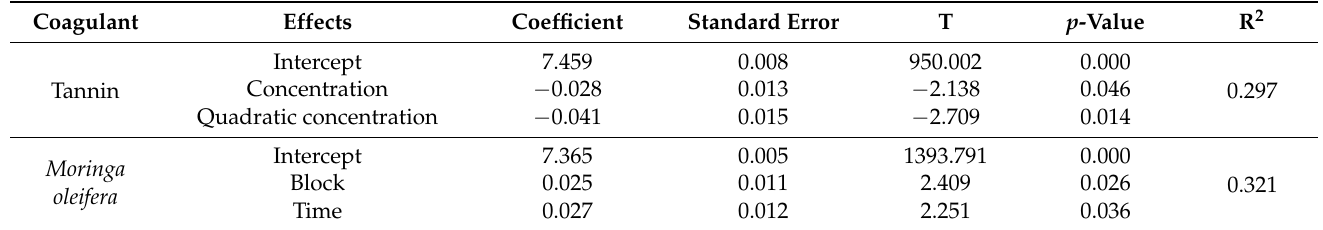
Table 3. Significant effects for the pH parameter for coagulation, flocculation, and sedimentation (C/F/S) process using tannin and Moringa oleifera in the presence and absence of magnetite.